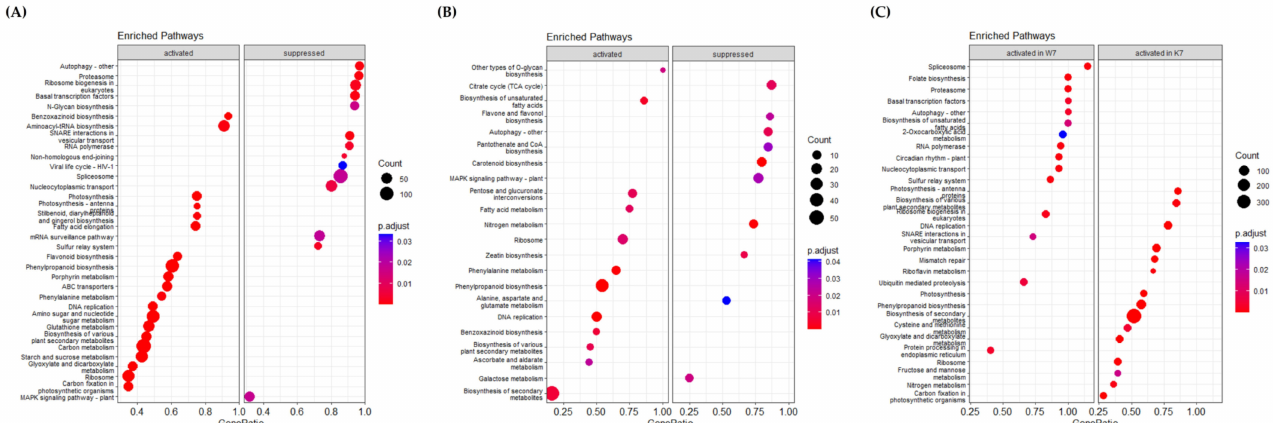
Figure 4. KEGG (Kyoto Encyclopedia of Genes and Genomes) pathway analysis for PHS-treated K0 vs. K7, W0 vs. W7, and K7 vs. W7 groups. GeneRatio on the X -axis is the ratio of the enhancement targets in the pathway to all targets annotated with KEGG, and the Y -axis lists the relevant functions. Each control group was divided into “activated” and “suppressed”. The size of the dot indicates the number of targets that could be annotated in the KEGG database, and the significance of the analysis was indicated by the p.adjust value. ( A ) KEGG analysis associated with identified DEGs in the K0 vs. K7 group. ( B ) KEGG analysis associated with identified DEGs in W0 vs. W7. ( C ) KEGG analysis associated with identified DEGs in the K7 vs. W7